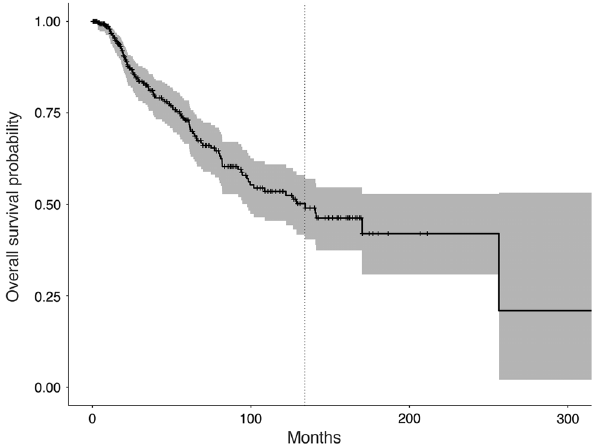
Figure 1. Kaplan–Meier plot of overall survival probability. Dotted vertical line indicates median survival time of 134.2 months.